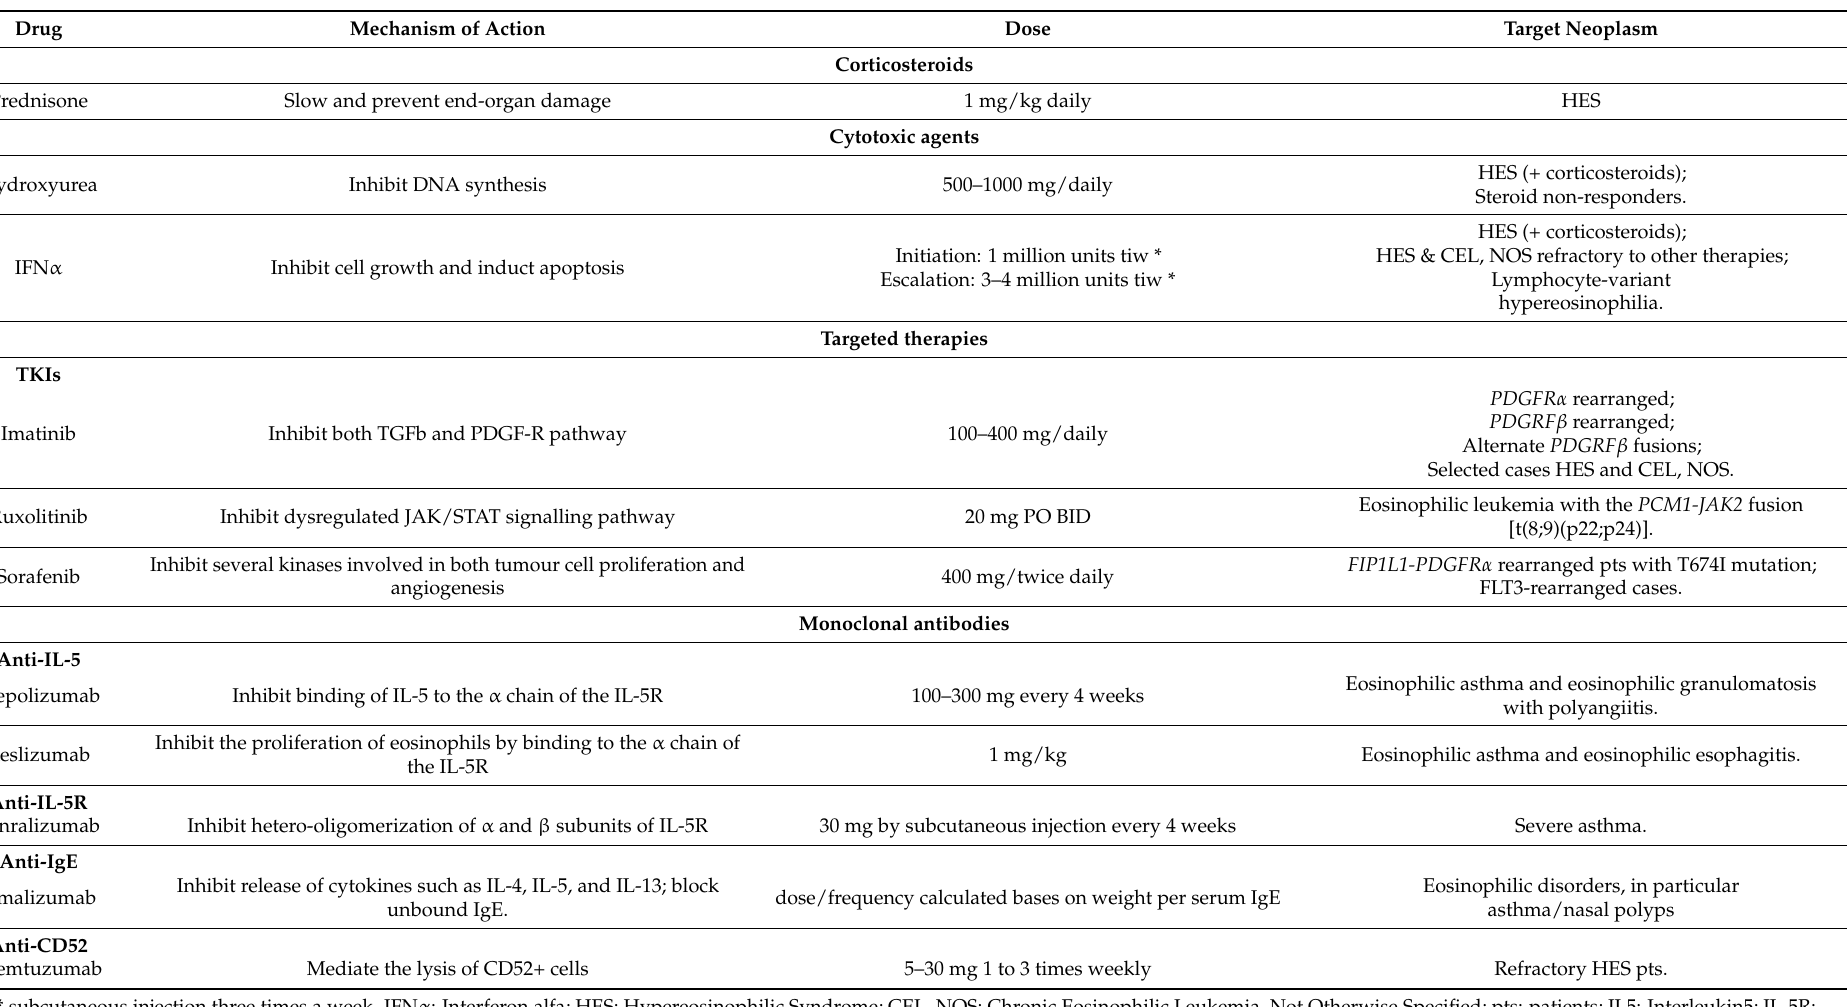
Table 2. Therapeutic options for eosinophilic